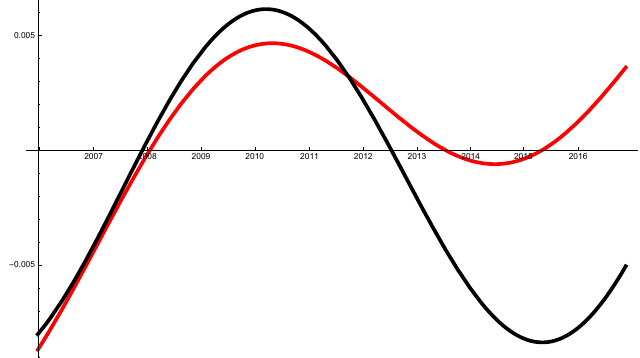
Figure 5. The x -axis represents time. The y -axis represents the value of the interaction coefficients of TECH (red) and WTI (black) between 2006 and